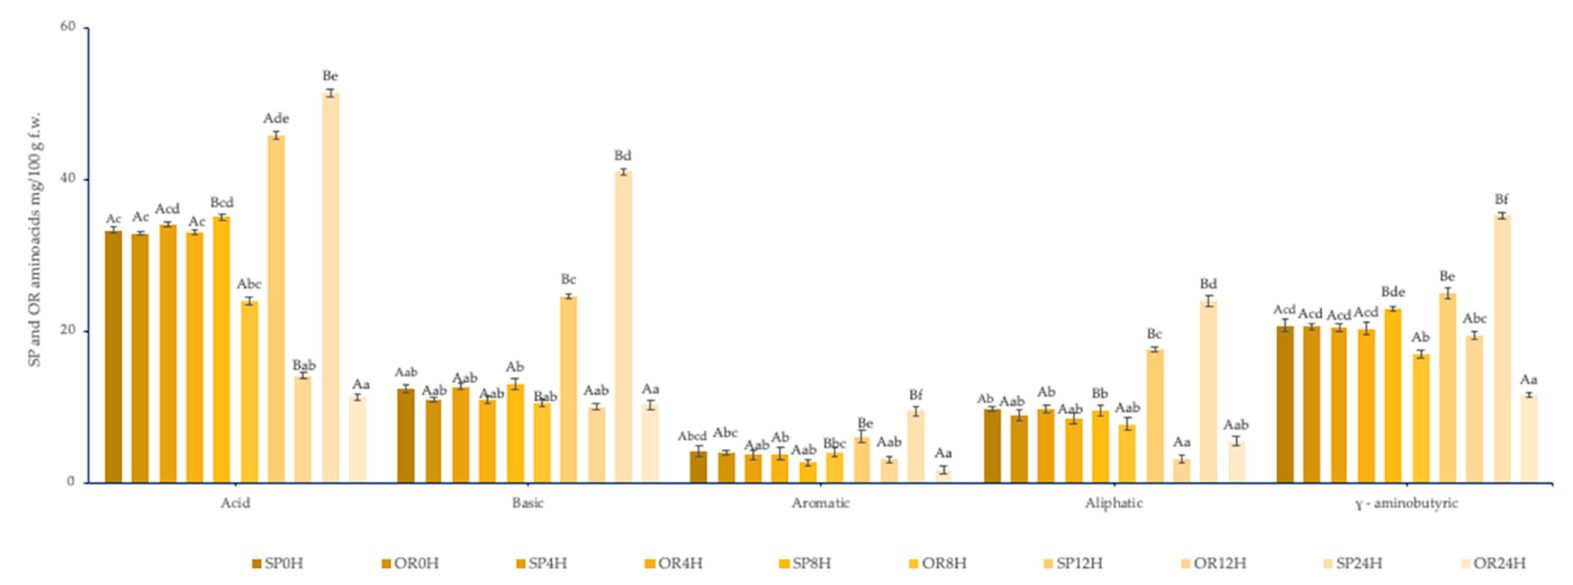
Figure 2. Amino acids content of sourdoughs with L. spicheri DSM 15429 (SP) and without L. spicheri DSM 15429 (OR) at different fermentation times: 0, 4, 8, 12, 24 h, (Values not sharing the same small letters indicate the significant difference between OR and SP at different moments; 0, 4, 8, 12, 24 h.; Values not sharing the same capital letters indicate the significant difference between OR and SP at the same moments: 0, 4, 8, 12, 24 h); f.w., fresh weight.